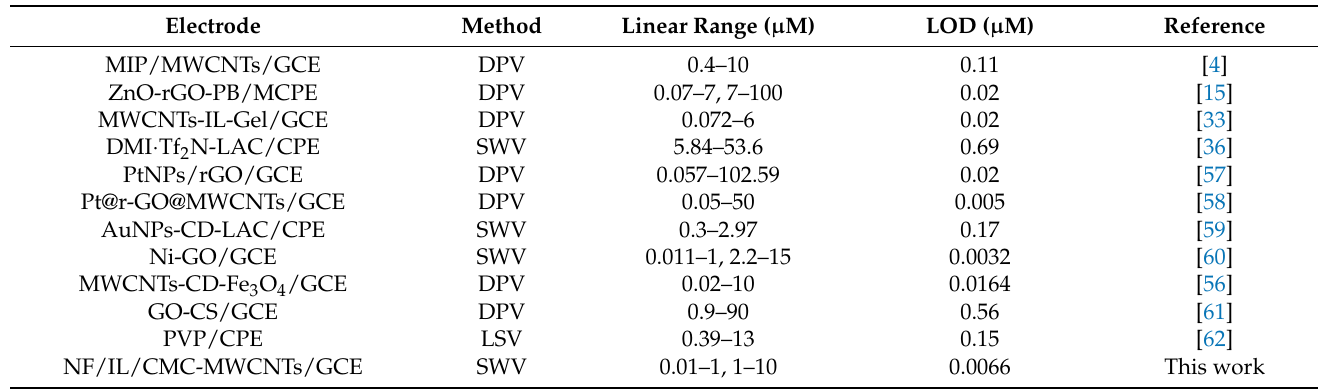
Table 1. Comparison of different modified electrodes for rutin